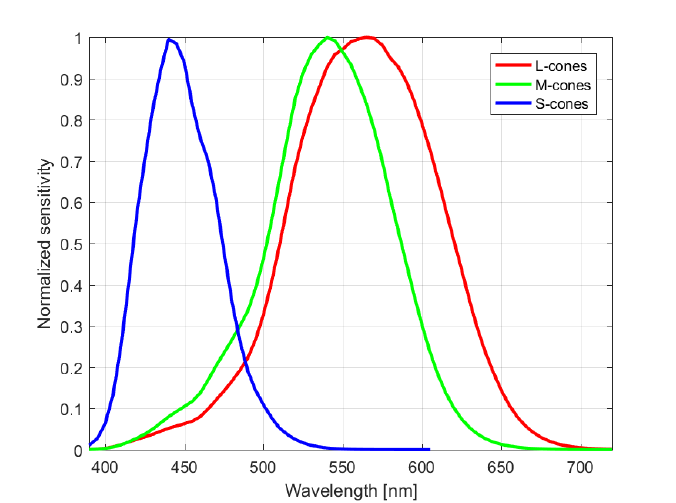
Figure 3. Spectral sensitivities of human cone